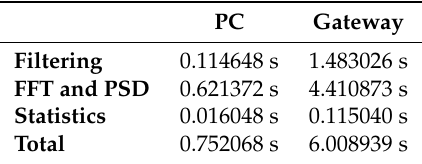
Table 4. Execution times for ECG analysis.